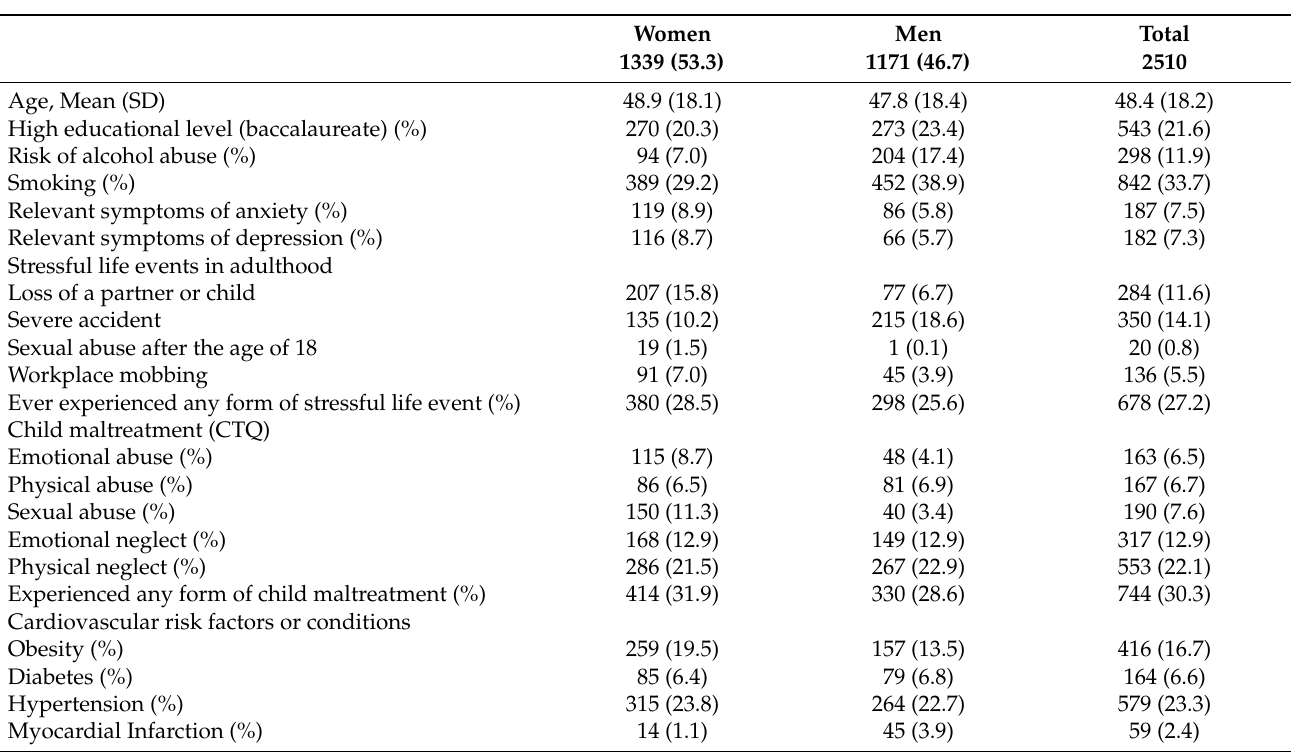
Table 1. Sample characteristics. Presented as number of participants (%) unless otherwise stated. Gender differences were assessed with Chi 2